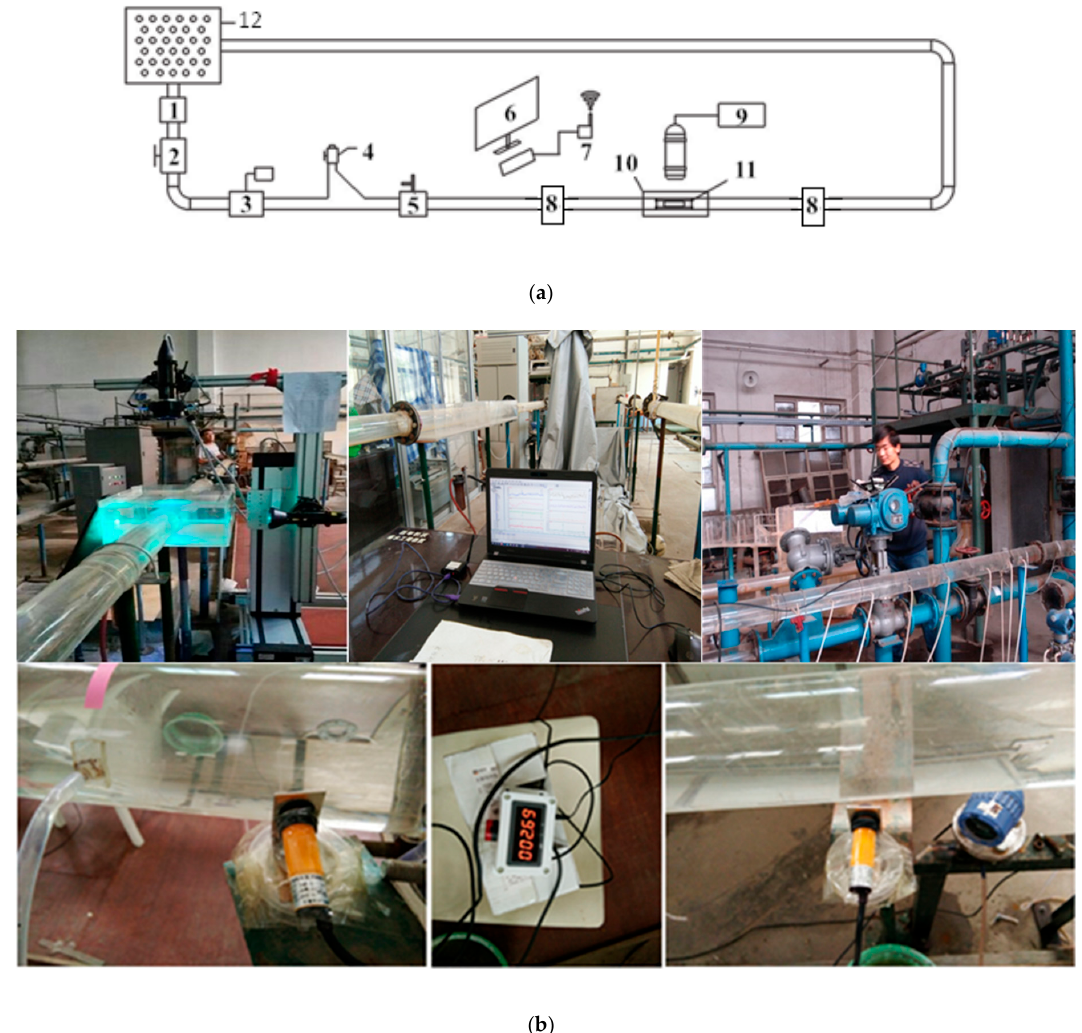
Figure 4. Experimental system device: ( a ) schematic diagram: 1. centrifugal pump; 2. regulating valve; 3. turbine flow meter; 4. capsule delivery device; 5. brake device; 6. computer; 7. flow velocity receiving device; 8. infrared sensor; 9. particle image velocimetry (PDA); 10. rectangular water jacket; 11. capsule; 12. water supply device and capsule receiving device; ( b ) physical diagram.